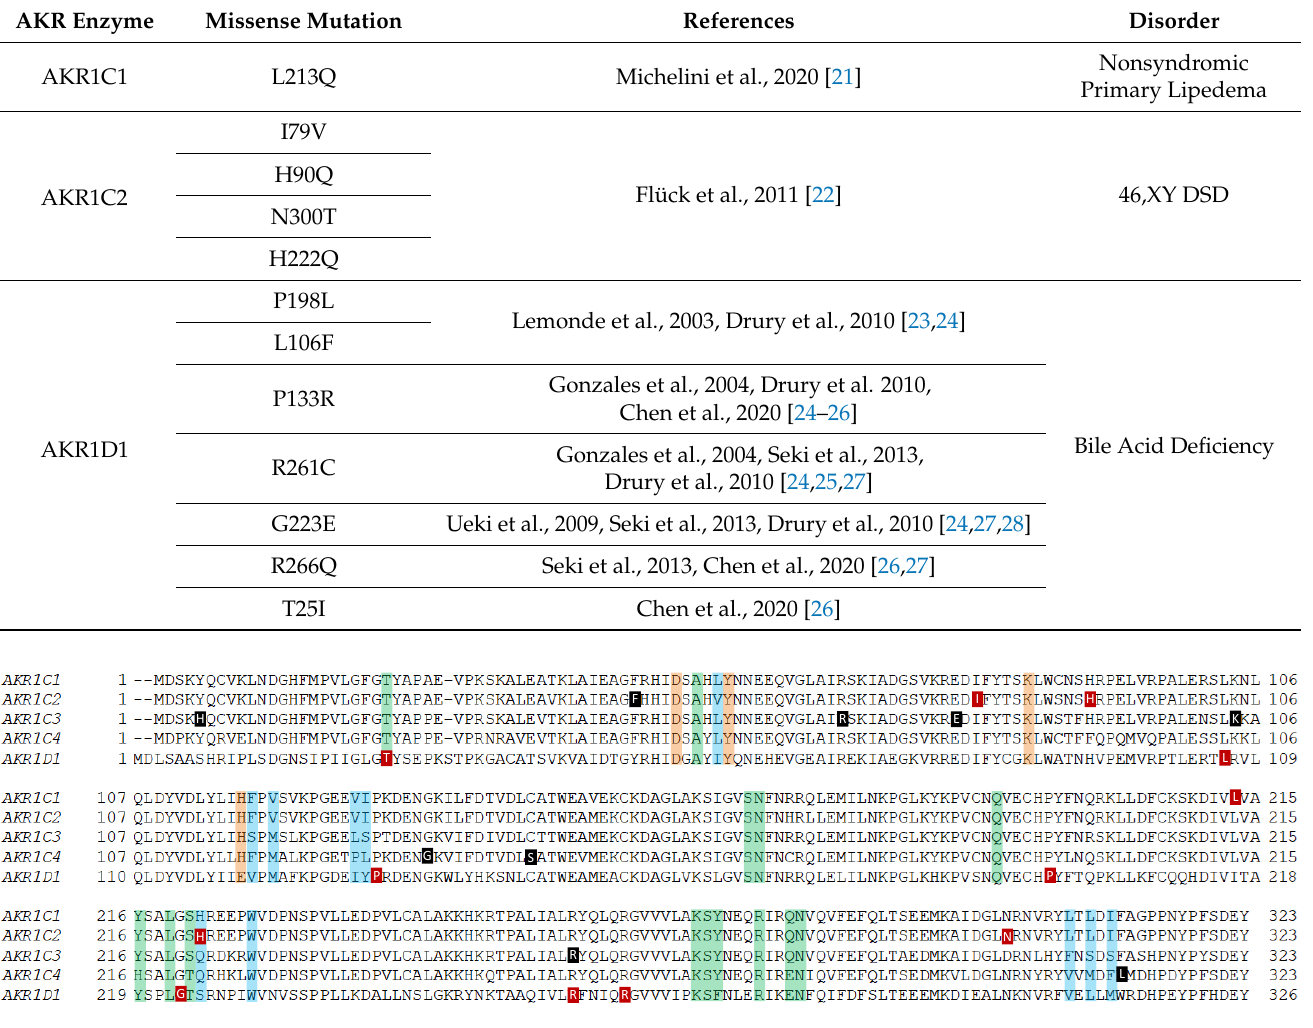
Figure 2. AKR sequence alignment shows the position of major nsSNPs and inherited mutations. Catalytic tetrad is shown in orange, steroid binding residues in blue, cofactor binding residues in green, nsSNPs with an MAF greater than 0.01 in black boxes, and familial mutations in red boxes. A 638 T > A transversion that results in a one amino acid substitution of L213 to Q in AKR1C1 was identified in a family with three members afflicted by sex-limited autosomal dominant nonsyndromic lipedema. Disease occurred in heterozygous carriers of the mutation. While the mutation did not affect protein expression in carriers, the L213Q variant was determined to be a loss-of-function mutation. L213 is not located on the active site. However, it is within the core of the protein, and its mutation appears to influence structure and function. Using molecular dynamic simulations, residue L213 was shown to participate in hydrophobic interactions. Mutation to glutamine disrupts these interactions due to the new polar side chain forming new hydrogen bonds. This mutation was found to affect the solvent accessibility of substrates with the steroid and cofactor binding pockets of AKR1C1. As a result of the structural changes, both steroid substrate and cofactor are more solvent-exposed, leading to a decrease in interaction energy between steroid substrate and cofactor that likely stems from a loss of non-covalent interactions. Quantitative structure- activity relationship (QSAR) modeling was performed to predict enzymatic parameters, where the mutant reduced both turnover number and catalytic efficiency by